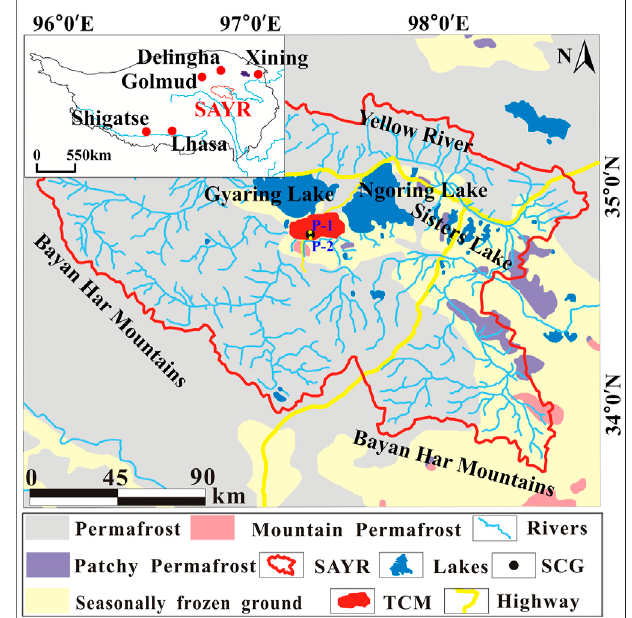
FIGURE 1 | Location of SAYR on the QTP and the sampling sites in the SCG